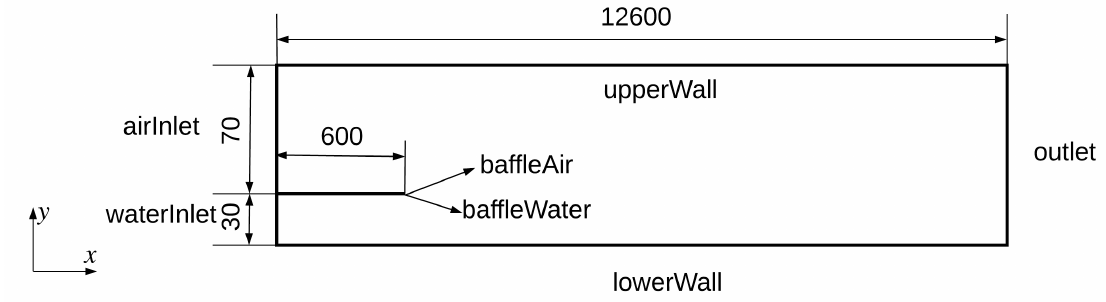
Figure 3. Sketch of the computational domain (units in mm, not to scale).